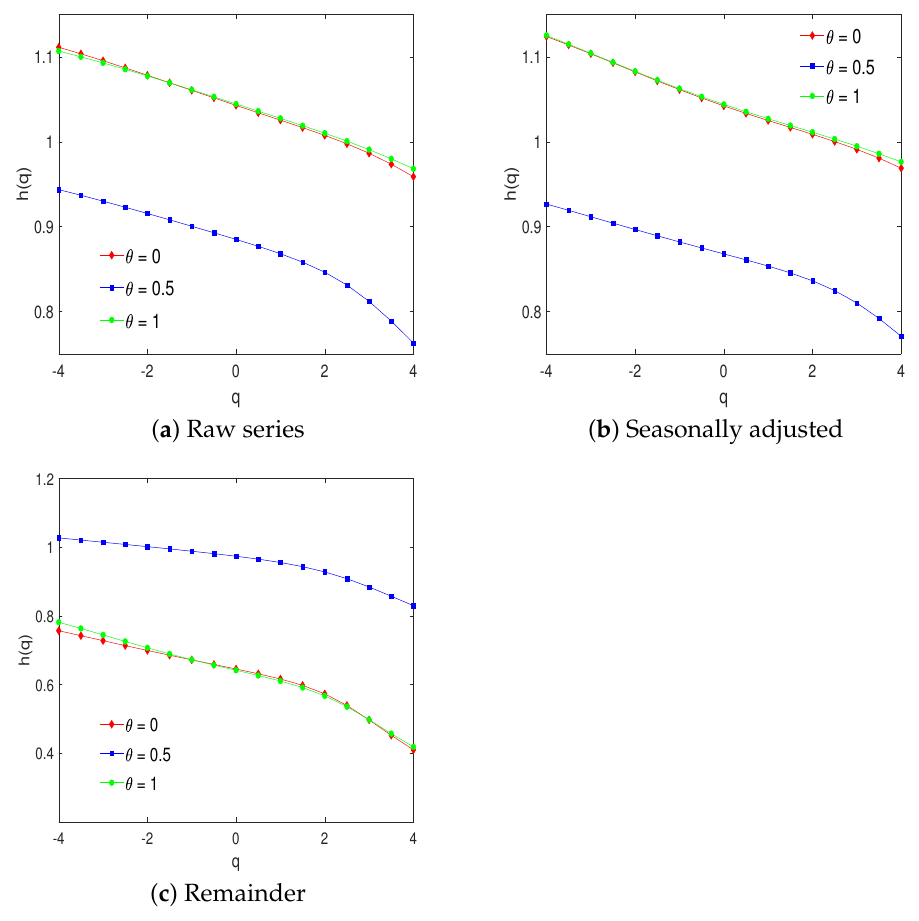
Figure 7. Generalized Hurst